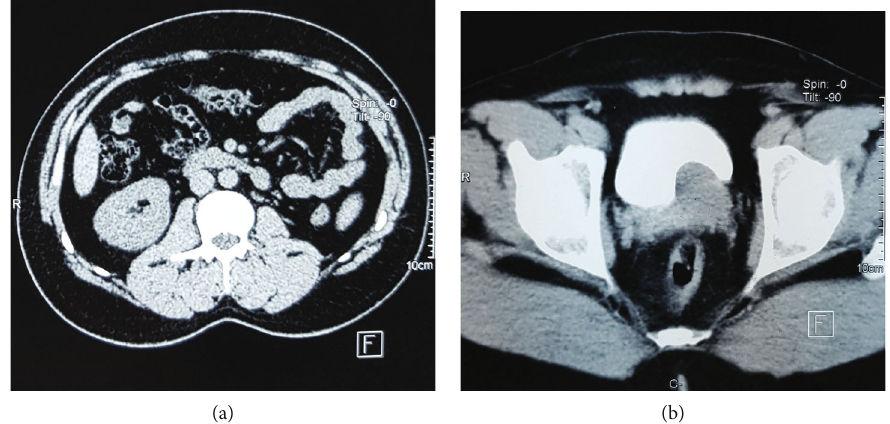
Figure 2: (a) Axial view of CT scan showing a single right kidney with empty left renal fossa; (b) CT scan of the pelvis revealing a homogeneous liquid mass retrovesical compressing the urinary bladder and protruding into the bladder lumen.